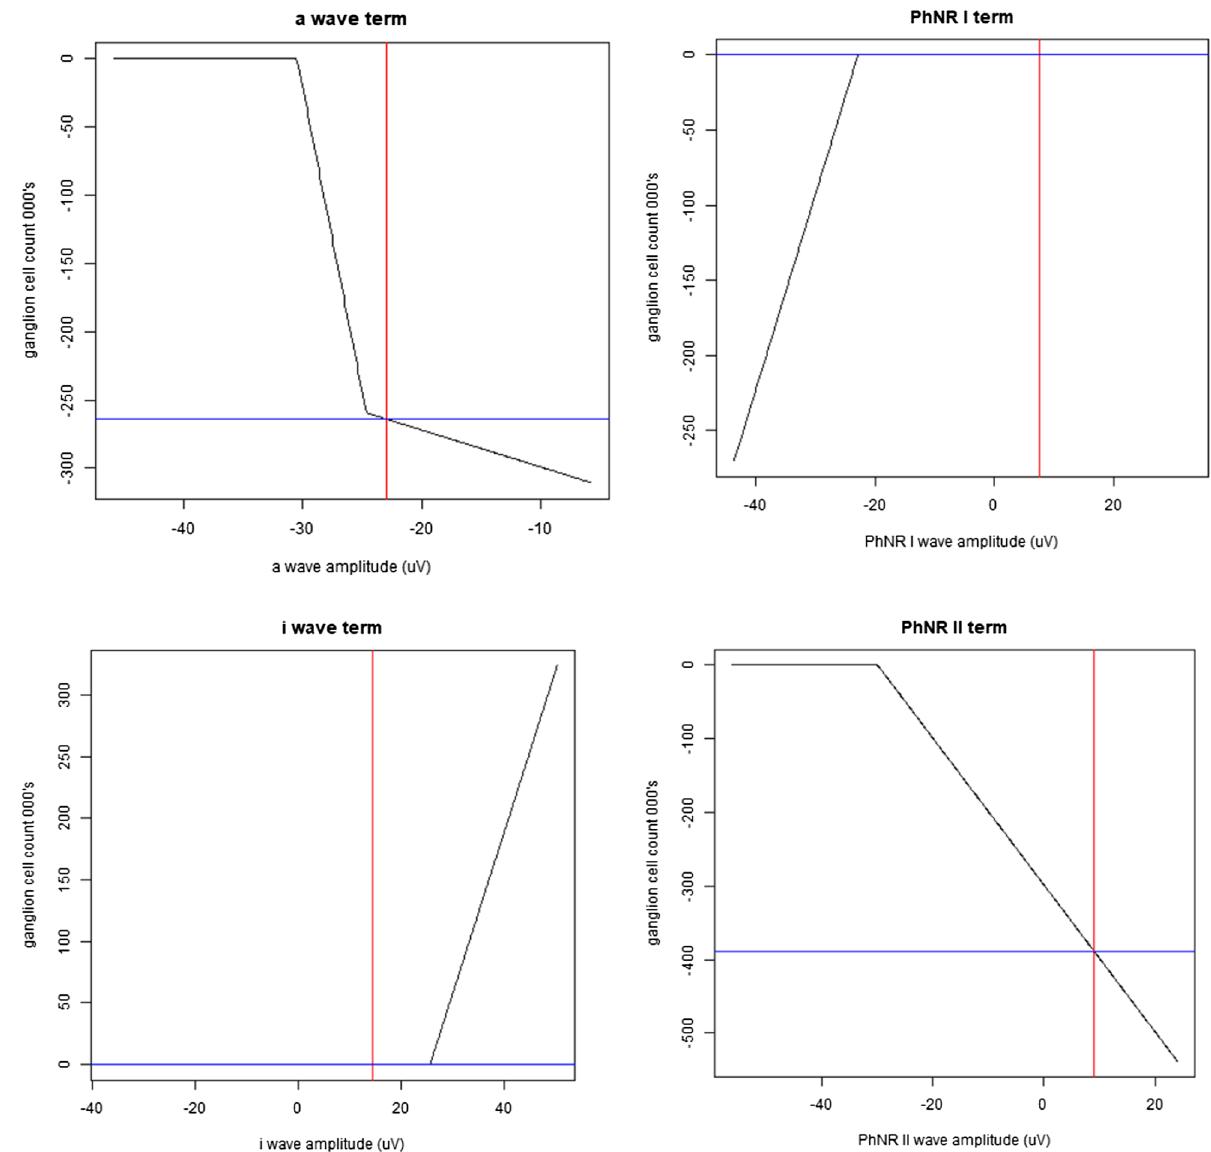
Figure 2. MARS model—achromatic stimulus. The panels represent the hinge functions and the influence of each term on the predicted estimate of retinal ganglion cells (eRGC). The red line shows amplitude of the various waves from an example eye. The effect on the eGRC for each term is shown on the vertical axis in each panel. The final eRGC is the intercept (940,162 retinal ganglion cells) plus the effect of each